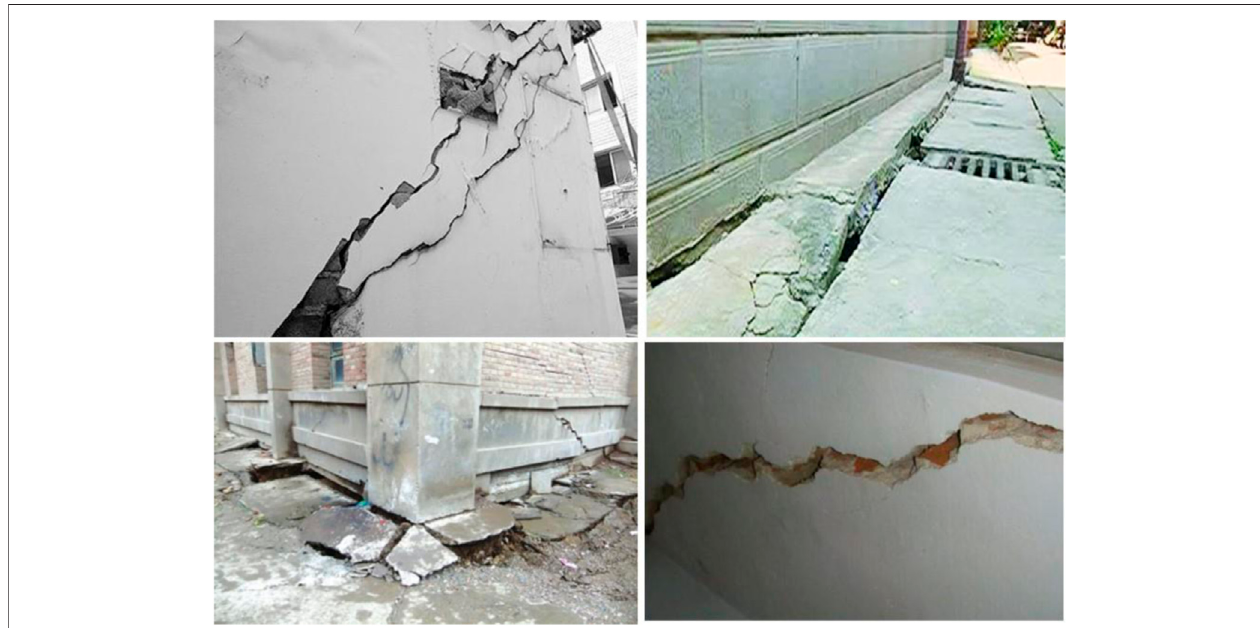
FIGURE 4 | Structural damages in some of the buildings selected for the case study area.